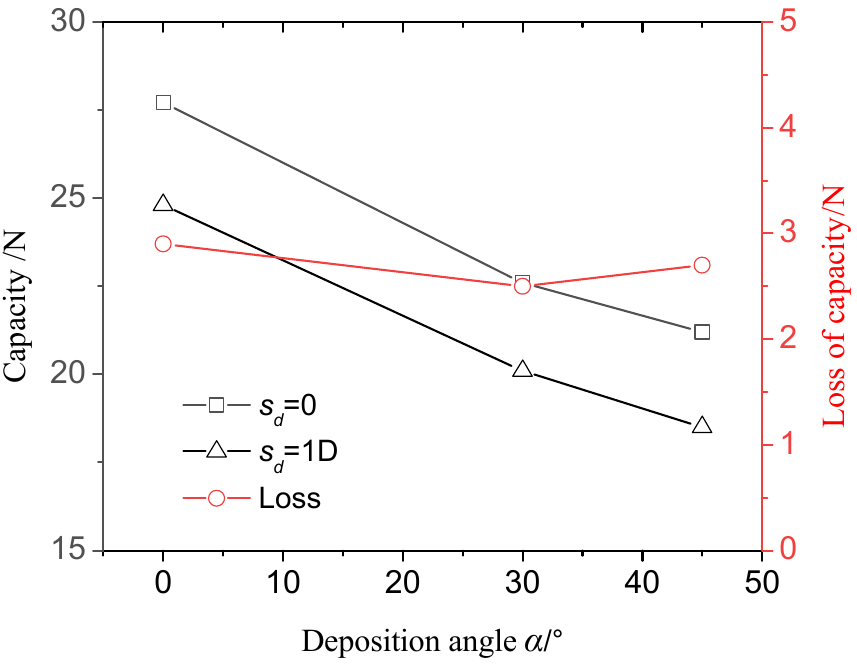
Figure 11. Variation of capacity to deposition angle α .